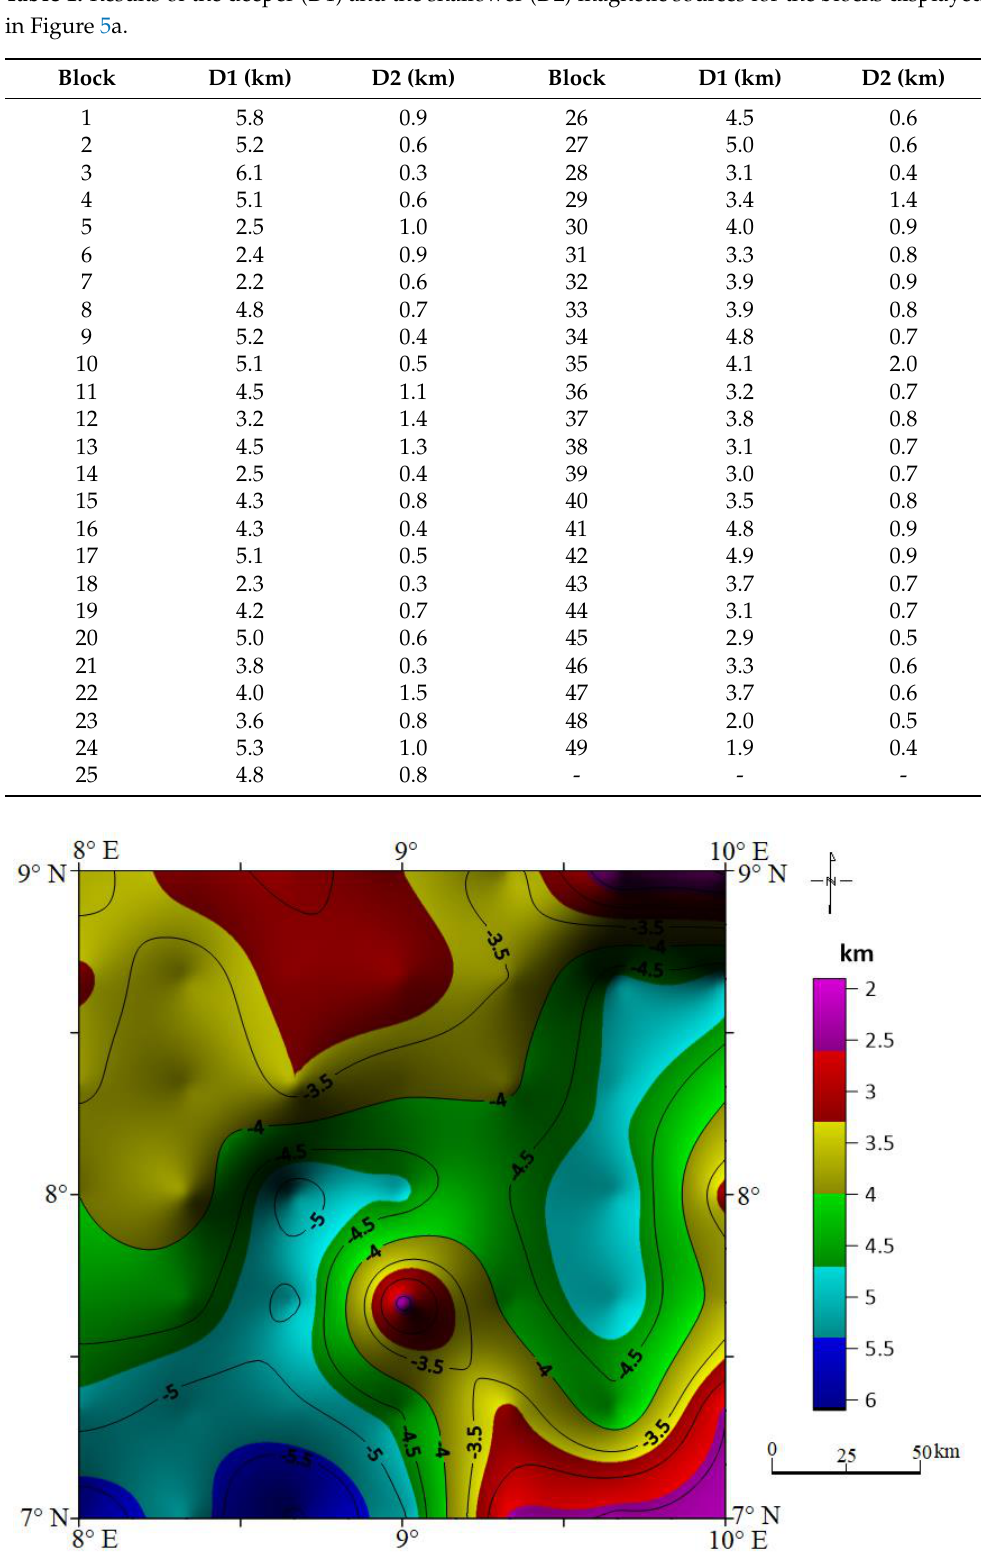
Figure 11. Map of the area’s deeper magnetic depth, which is assumed to coincide with the basement surface. The contours indicate depth from ground surface to the top of basement.